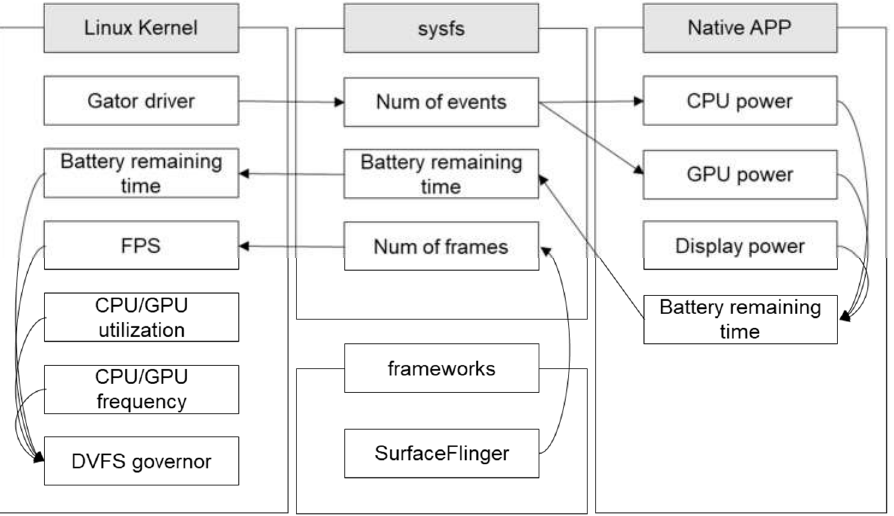
Figure 10. Diagram of the proposed system configuration diagram on the Android platform.